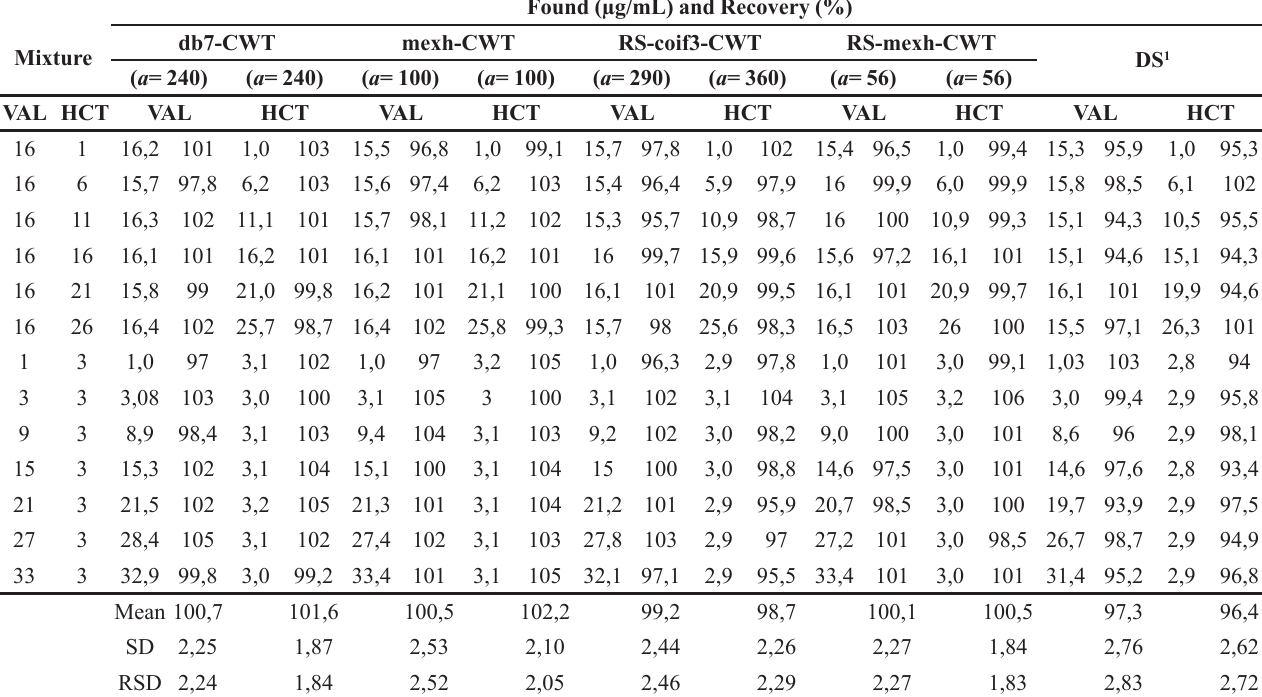
Found (µg/mL) and Recovery